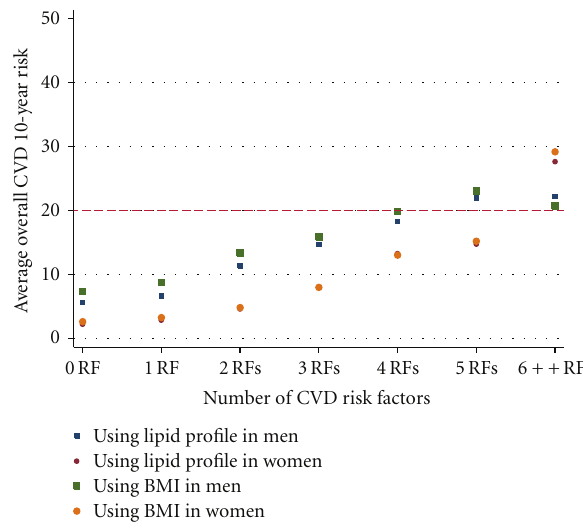
Figure 2: Trends of average overall cardiovascular disease risk by the number of risk